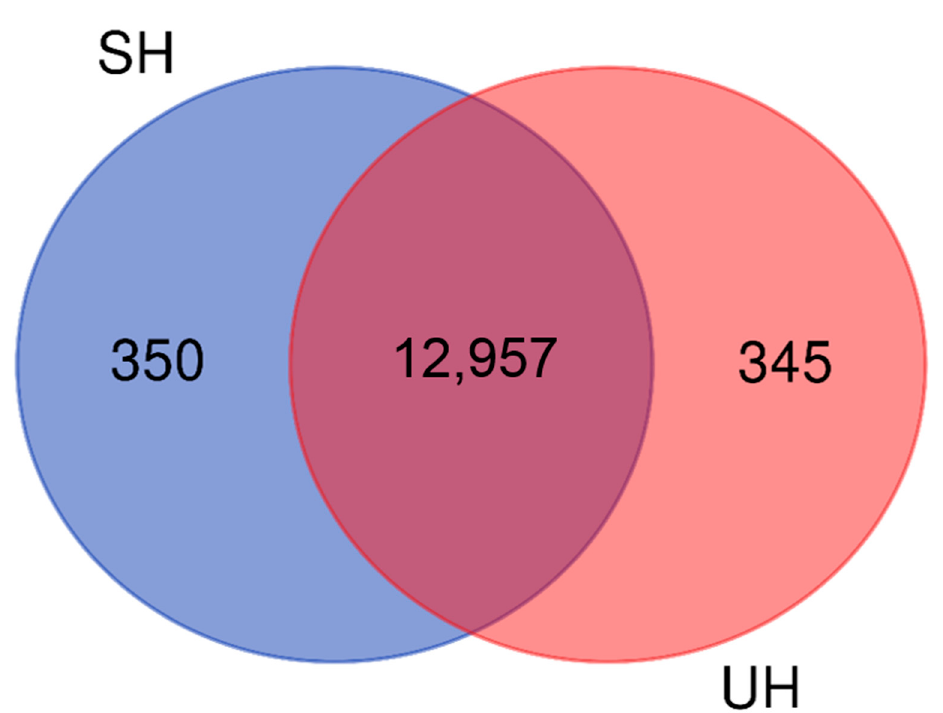
Figure 3. Distribution of transcripts identified in the pig inguinal and umbilical ring tissue samples. Legend: SH—scrotal hernia group; UH—umbilical hernia group. For the SH, the inguinal ring tissue was evaluated, and for the UH, the umbilical ring tissue was analyzed.